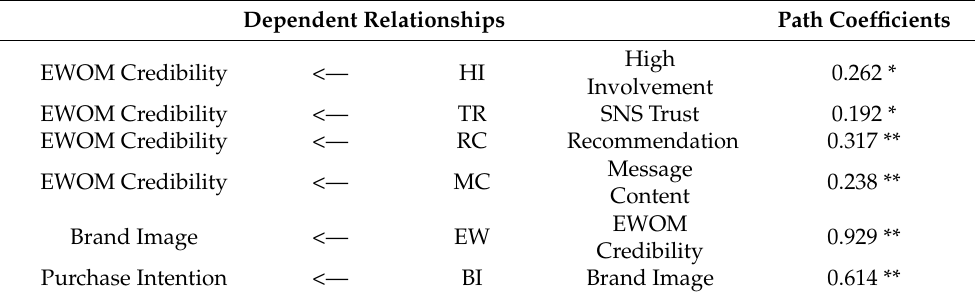
Table 4. Structural model—path analysis. Dependent Relationships Path